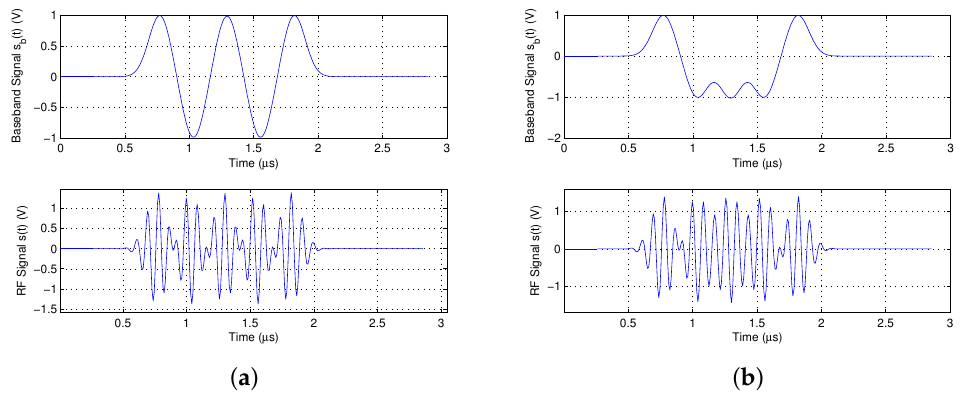
Figure 3. The baseband waveform and RF waveform of the pulse shaping signal. ( a ) Data stream { 1, − 1,1, − 1,1 } ; ( b ) data stream { 1, − 1, − 1, − 1,1 }